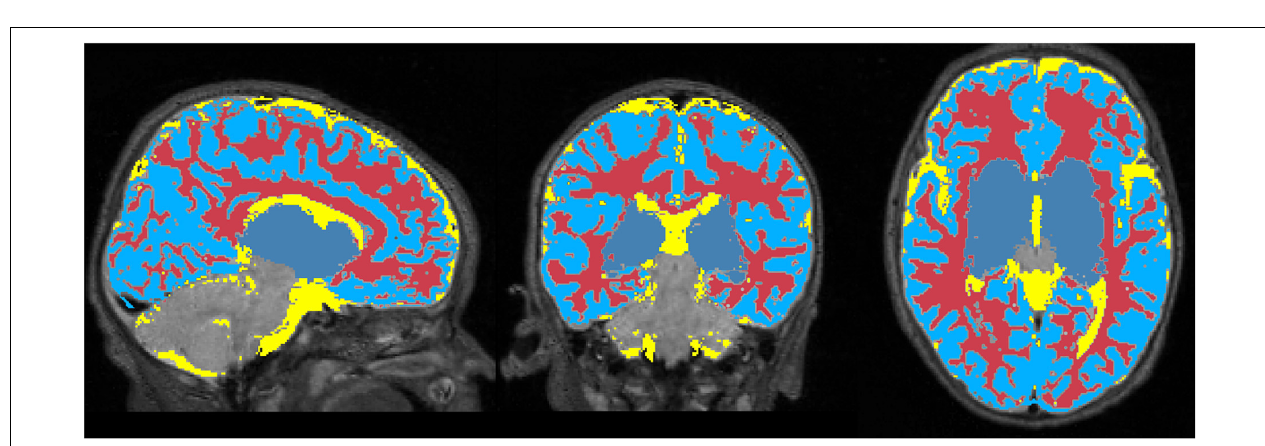
FIGURE 6 | One millimeter isotropic masks created from the tissue probability maps obtained with Mantis. White matter (red), CSF (yellow), gray matter (blue).